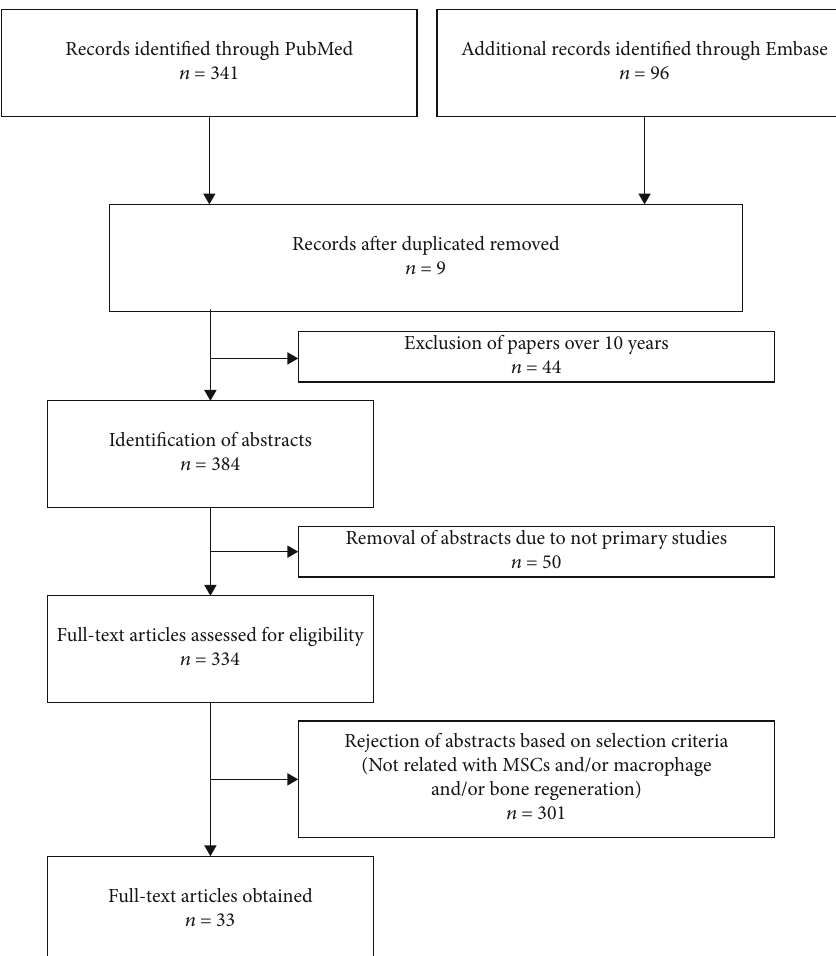
Figure 1: Flow diagram of the systematic review on the crosstalk of MSCs and macrophages. A total of 437 studies were retrieved based on the search strategy mentioned in the methods. Nine records after duplicates were removed. 44 works of literature published more than 10 years were excluded. After reviewing the titles and abstracts, 50 records were removed because the studies were not primary studies. After reviewing the titles and abstracts, 301 records were removed because the studies did not match the selection criteria. Finally, 33 studies met the inclusion criteria and were selected for this systematic